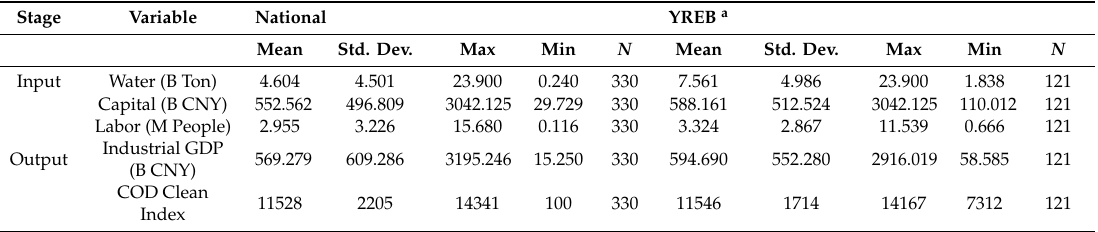
Table 3. Descriptive statistics of variables (2005–2015).